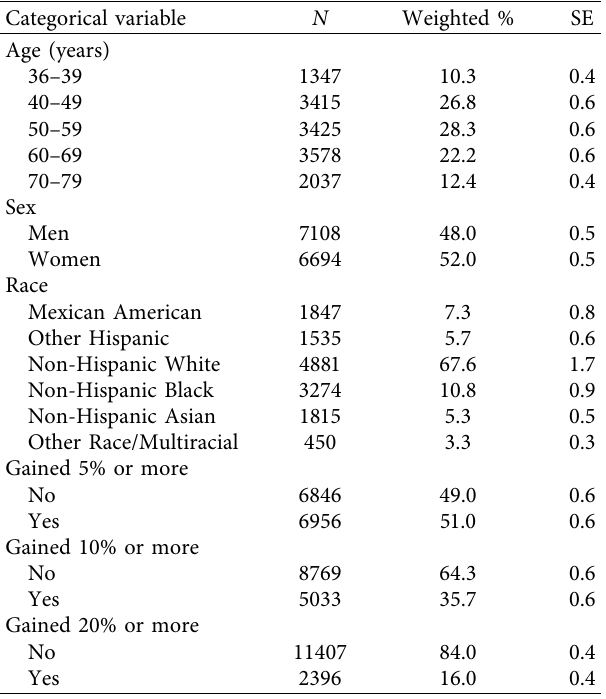
Table 1: Descriptive characteristics of the sample ( n �